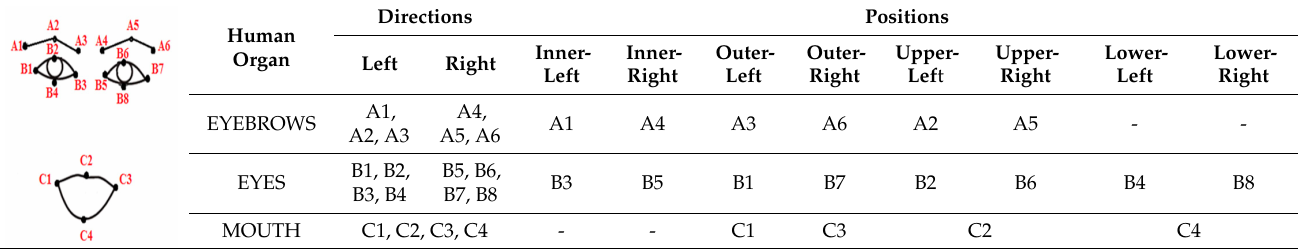
Table 1. Standard marked feature on human